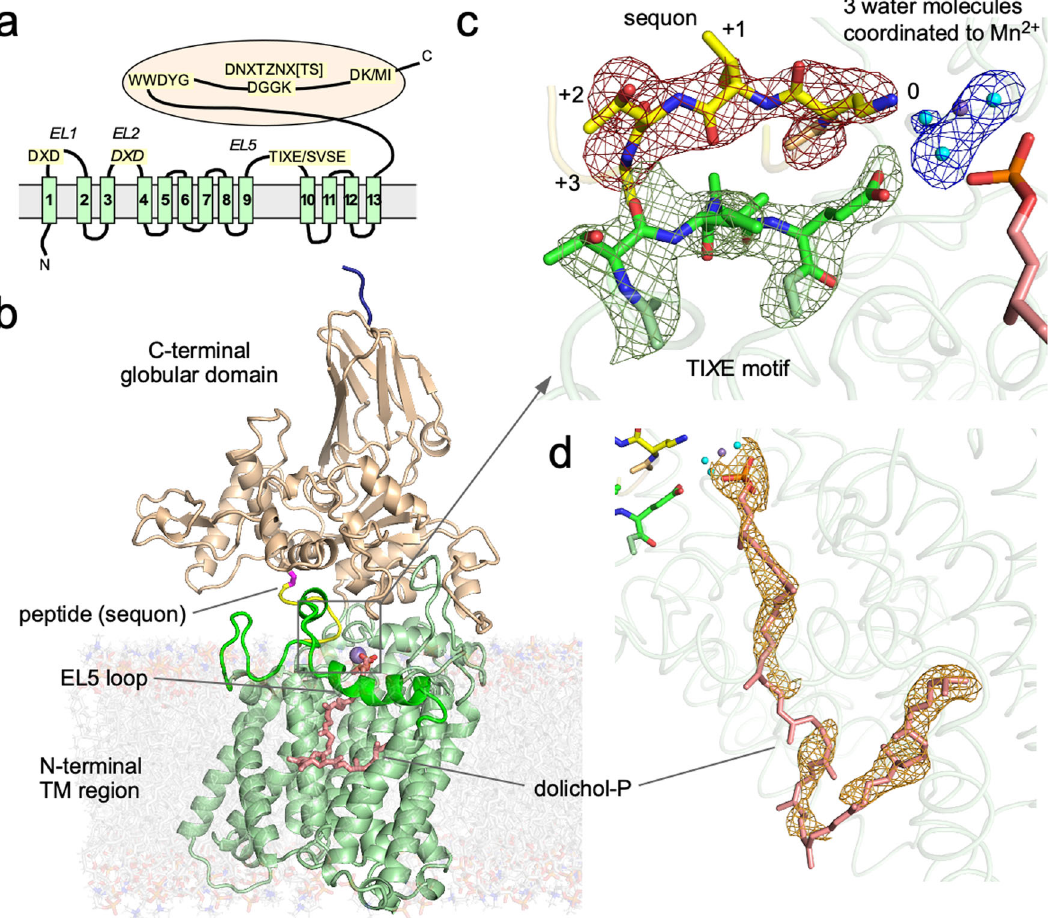
Fig. 1 Structure of conserved amino acid motifs in the ternary complex. a Positions of the short, conserved motifs on the amino acid sequence of the catalytic subunit, Stt3/AglB/PglB, of the OST enzyme. b Ribbon representation of Af AglB with the N-terminal transmembrane region in pale green and the C-terminal globular domain in wheat, embedded in a model DOPC lipid bilayer (transparent). The four extra residues in the spacer sequence, retained after the removal of the C-terminal His-tag, are modeled and colored dark blue. The EL5 loop is green, the Mn 2 + is shown as a purple sphere, and the dolichol- phosphate is shown as salmon sticks. The bound acceptor peptide is shown as a yellow loop and the disul fi de bond for tethering is magenta. c Close-up view of the catalytic site. The red mesh depicts an omit electron density map of the sequon segment (yellow sticks). The numbers indicate sequon positions relative to the acceptor Asn. The green mesh depicts an omit map of the TI X E motif segment (green sticks). The dark blue mesh depicts an omit map of the three water molecules (cyan spheres) coordinated to Mn 2 + . These three omit maps were calculated independently, after removing the relevant segment/molecules. Each map is only shown around the segment/molecules contoured at 3 σ . The TAMRA dye at the N-terminus of the peptide was invisible in the maps, suggesting the absence of speci fi c interactions with the protein. d Close-up view of the bound dolichol-phosphate. The orange mesh depicts an omit map contoured at 2 σ and is only shown around the